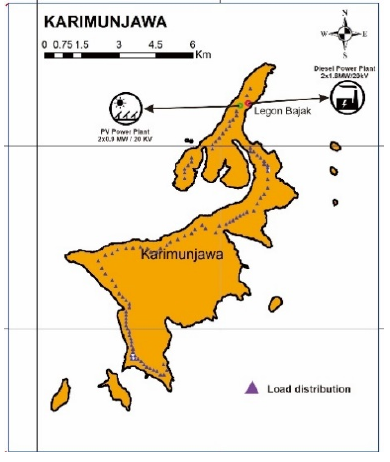
Figure 6. Load distribution and PV, DPP system location.